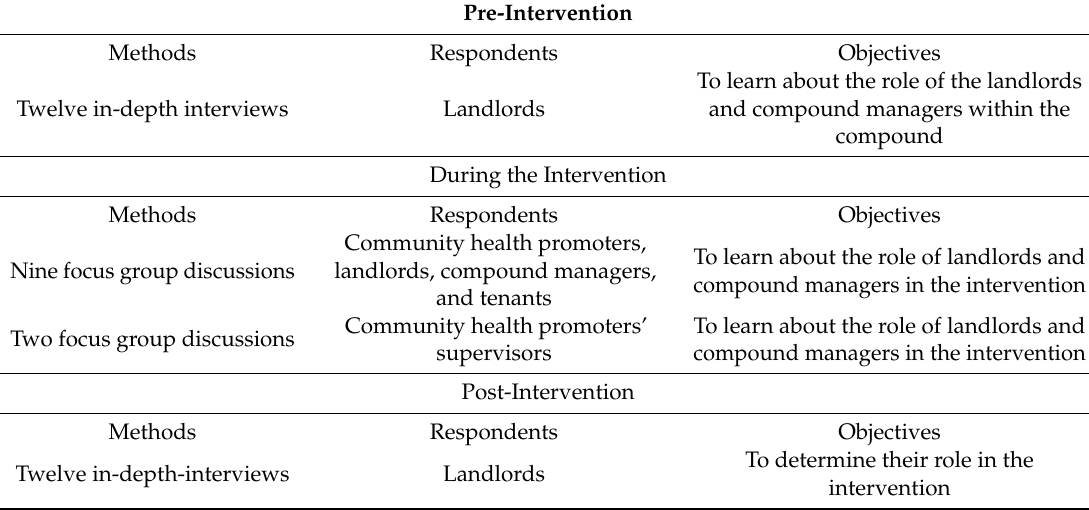
Table 1. A summary of data collection for pre-intervention, during the intervention, and